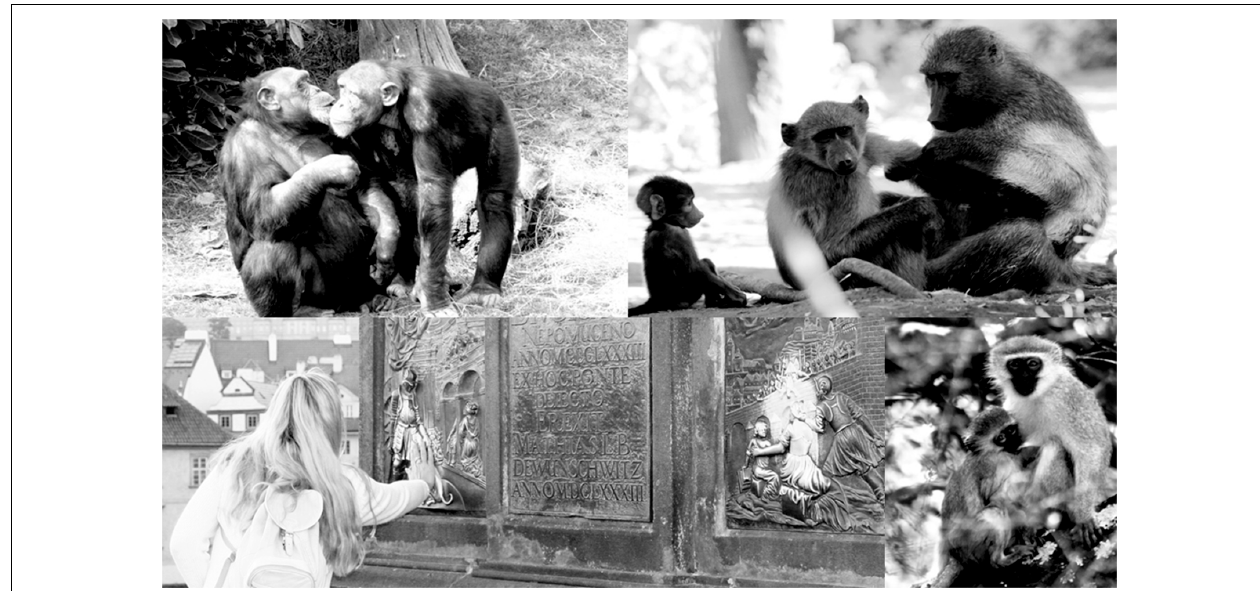
Papio cynocephalus ): where groomers may feed on ectoparasites or food-debris, allowing for the transmission of microbiota; ( bottom-right ) lactation (in vervet monkeys, Chlorocebus aethiops ): where microbiota directly acquired from the mother helps feeding bacterial communities which in turn help offspring assimilating milk’s nutrients; and ( bottom-left ), indirect transmission of microbiota mediated by a social tradition (i.e., touching religious objects), a possible pathway for the homogenization of microbial-life across individuals of a culturally defined human group (all photos by Augusto J.